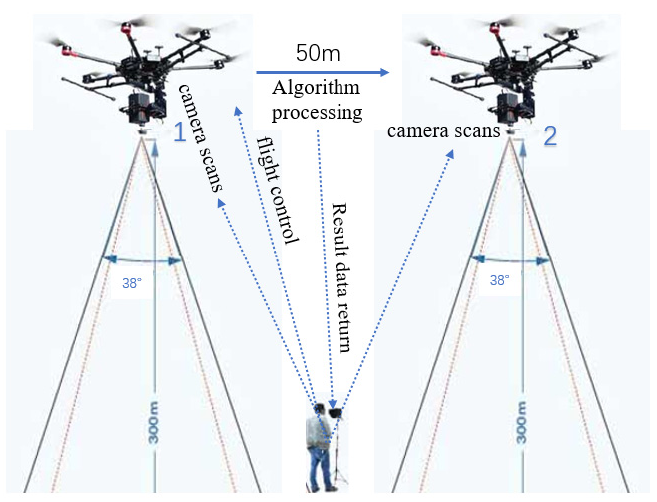
Figure 13. Schematic diagram of the flight experiment.